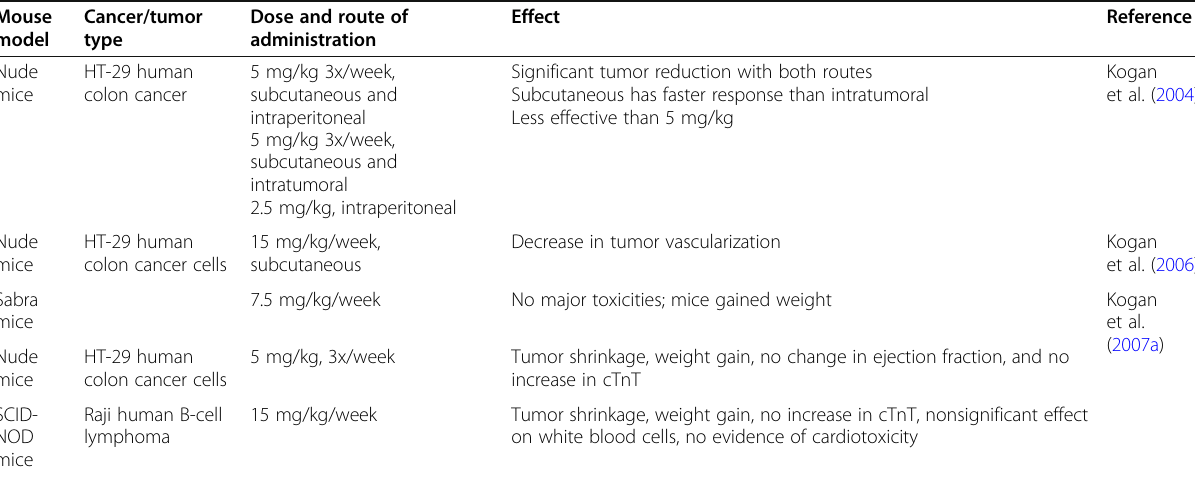
Table 2 Results from animal model-based experiments with HU-331 Mouse